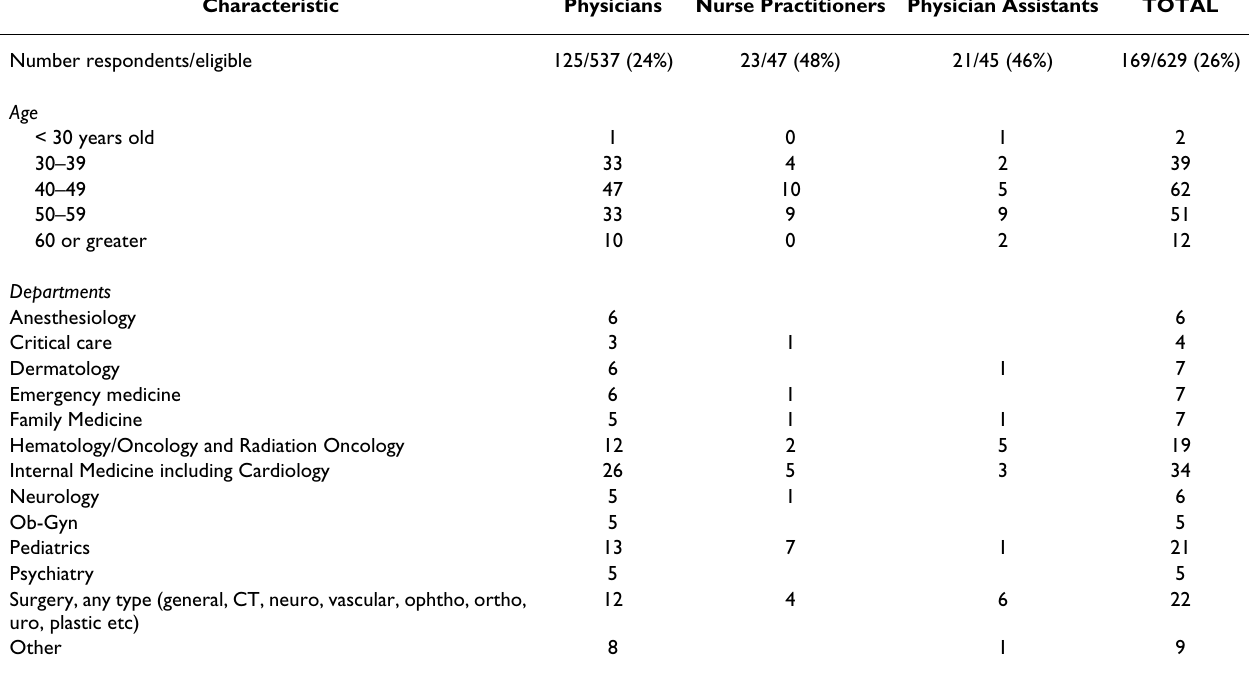
Table 1: Respondent Characteristics